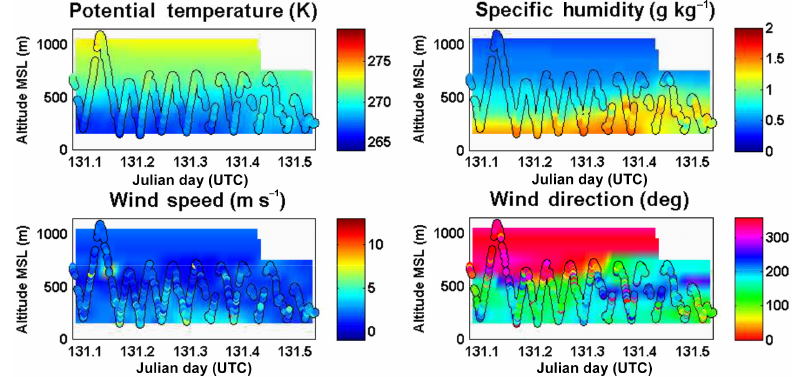
Figure 11. Potential temperature, specific humidity, wind speed and wind direction determined from the CMET balloon observations (131.08 to 131.52 JD, equivalent to ∼ 02 to 12.5 UTC on 11 May) of flight 5 during a series of automated soundings between 150 and 700m altitude. Data between the balloon soundings has been interpolated.